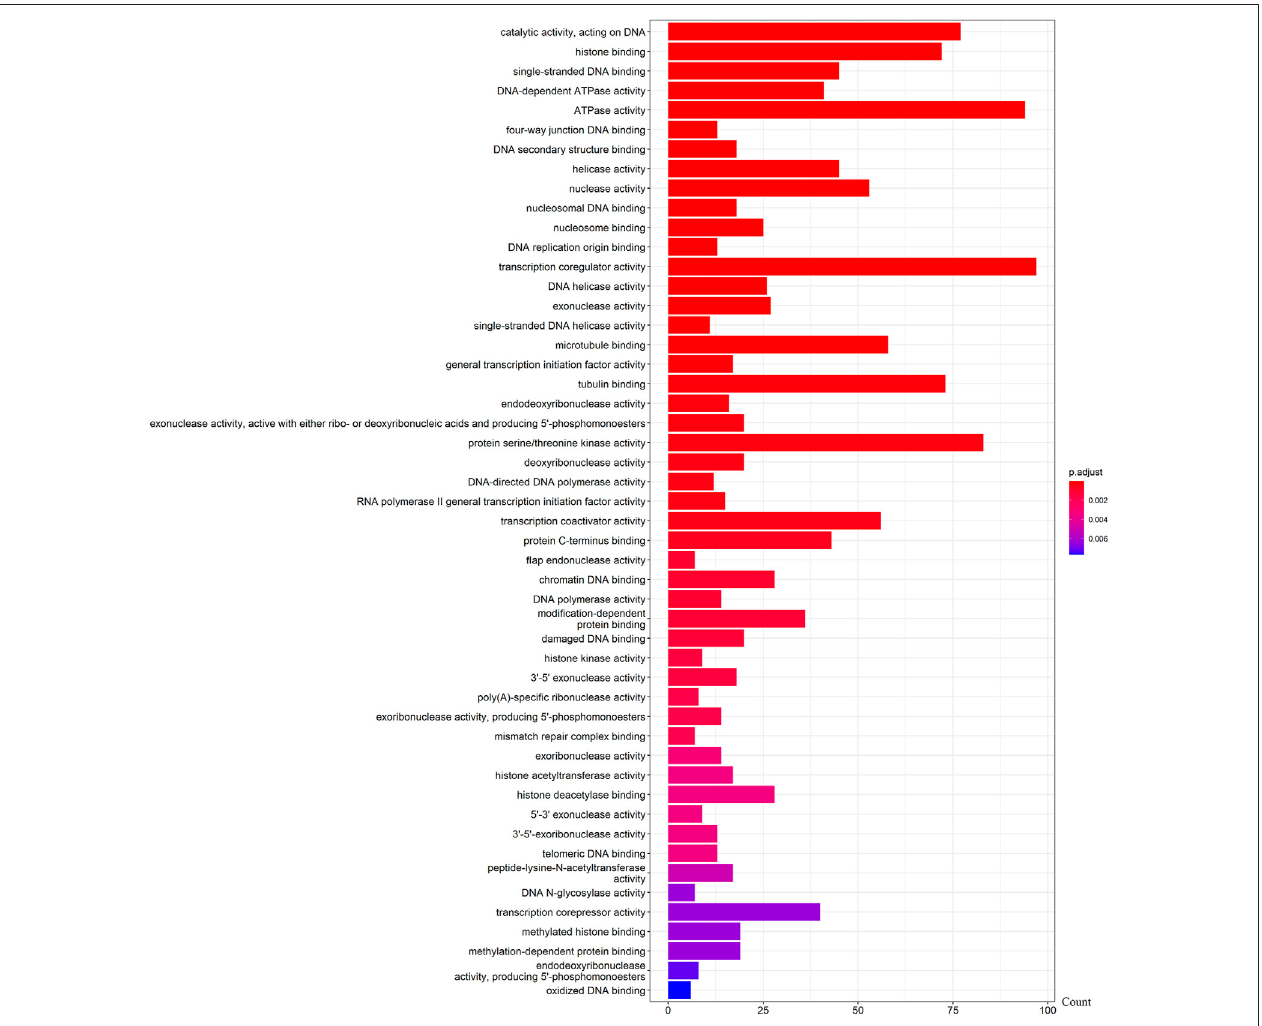
FIGURE 7 | GO analysis of AC004943.1 target genes. Note: The target genes of lncRNAs were identi fi ed from Pearson ’ s correlation analysis (|correlation coef fi cient| > 0.4 and p < 0.001), GO analysis were performed in “ clusterPro fi ler ” and “ org.Hs.eg.db ” of R software to generated these functional pathways.